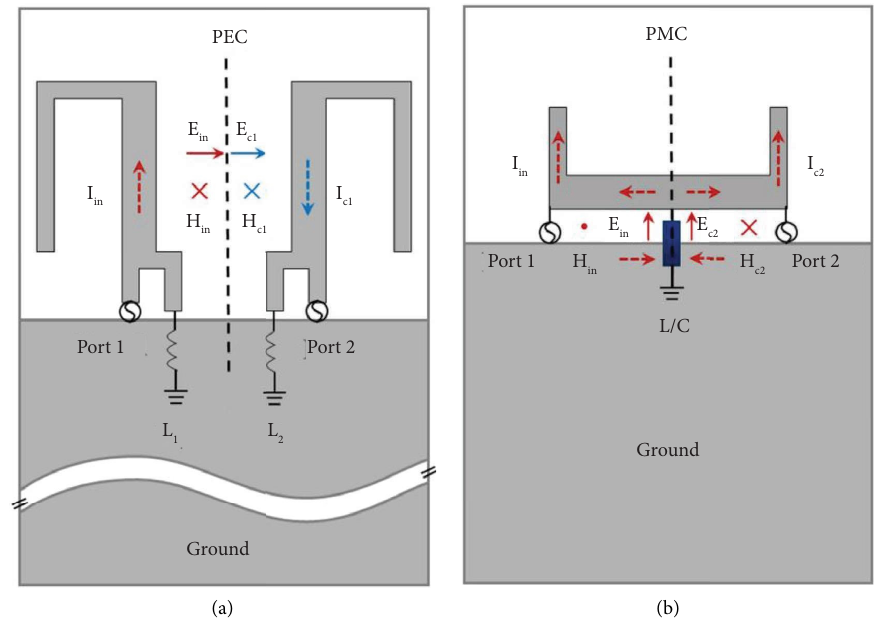
Figure 1: (a) Te symmetric plane of the conventional antenna model without decoupling elements, which is equivalent to a perfect electric conductor (PEC). (b) Te symmetric plane of the proposed general PMC equivalent structure, which is equivalent to a perfect magnetic conductor (PMC).